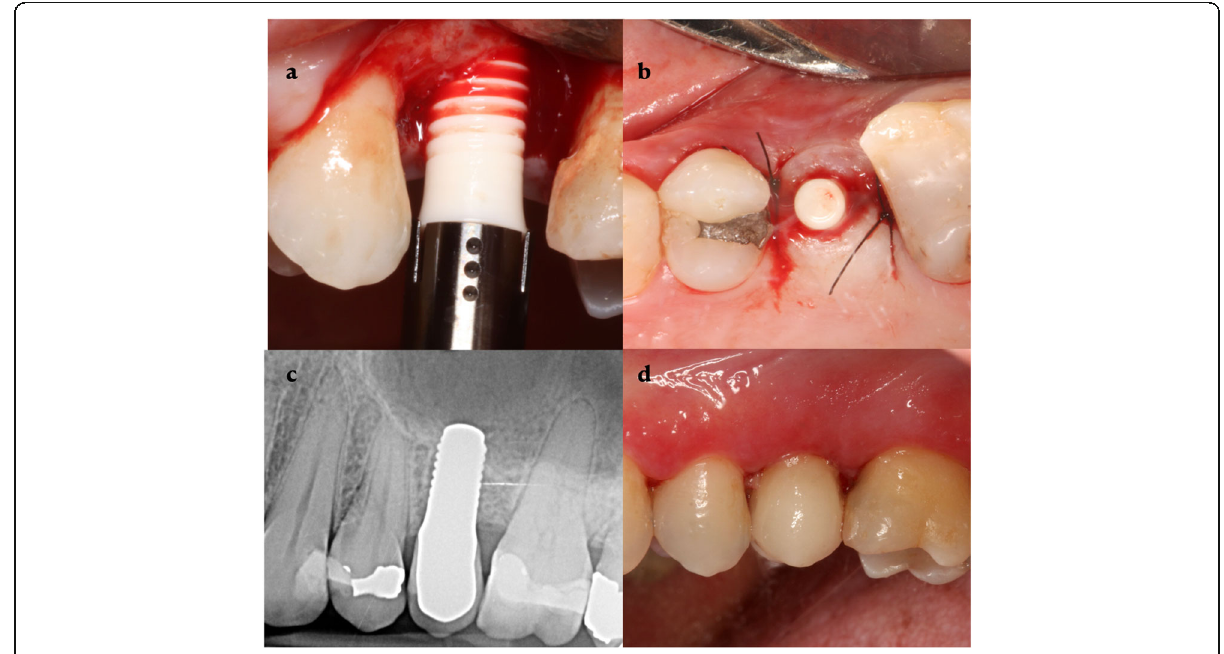
Fig. 1 Clinical case. a Surgery, b implant placed, c radiographic evaluation at 12 months, and d prosthesis at 12